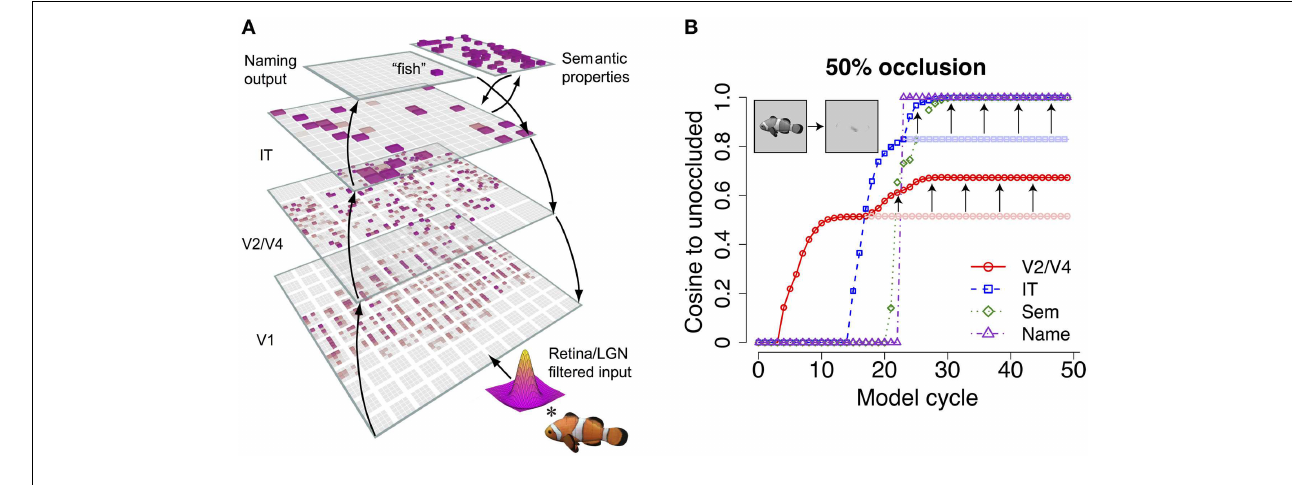
in the representation with respect to the veridical (i.e., unoccluded) representation at different areas within the model. Pale colors indicate the predicted response without top-down feedback, which is asymptotic.The Sem area exhibits a similar enhancement pattern to areasV2/V4 and IT, but is left unannotated on the plot for clarity. V2/V4 = extrastriate cortex; IT = inferotemporal cortex; Sem = amodal semantic responses, such as those demonstrated by anterior IT neurons; Name = named output